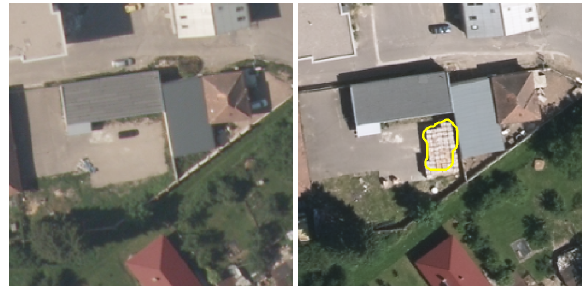
Figure 14. Left: aerial image (2010) Right: aerial image